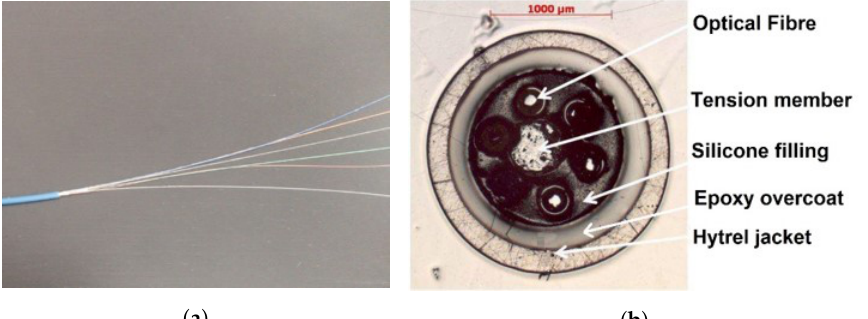
Figure 5. ( a ) Photo of the optical cable. ( b ) Micrography of different constitutive layers of the optical cable